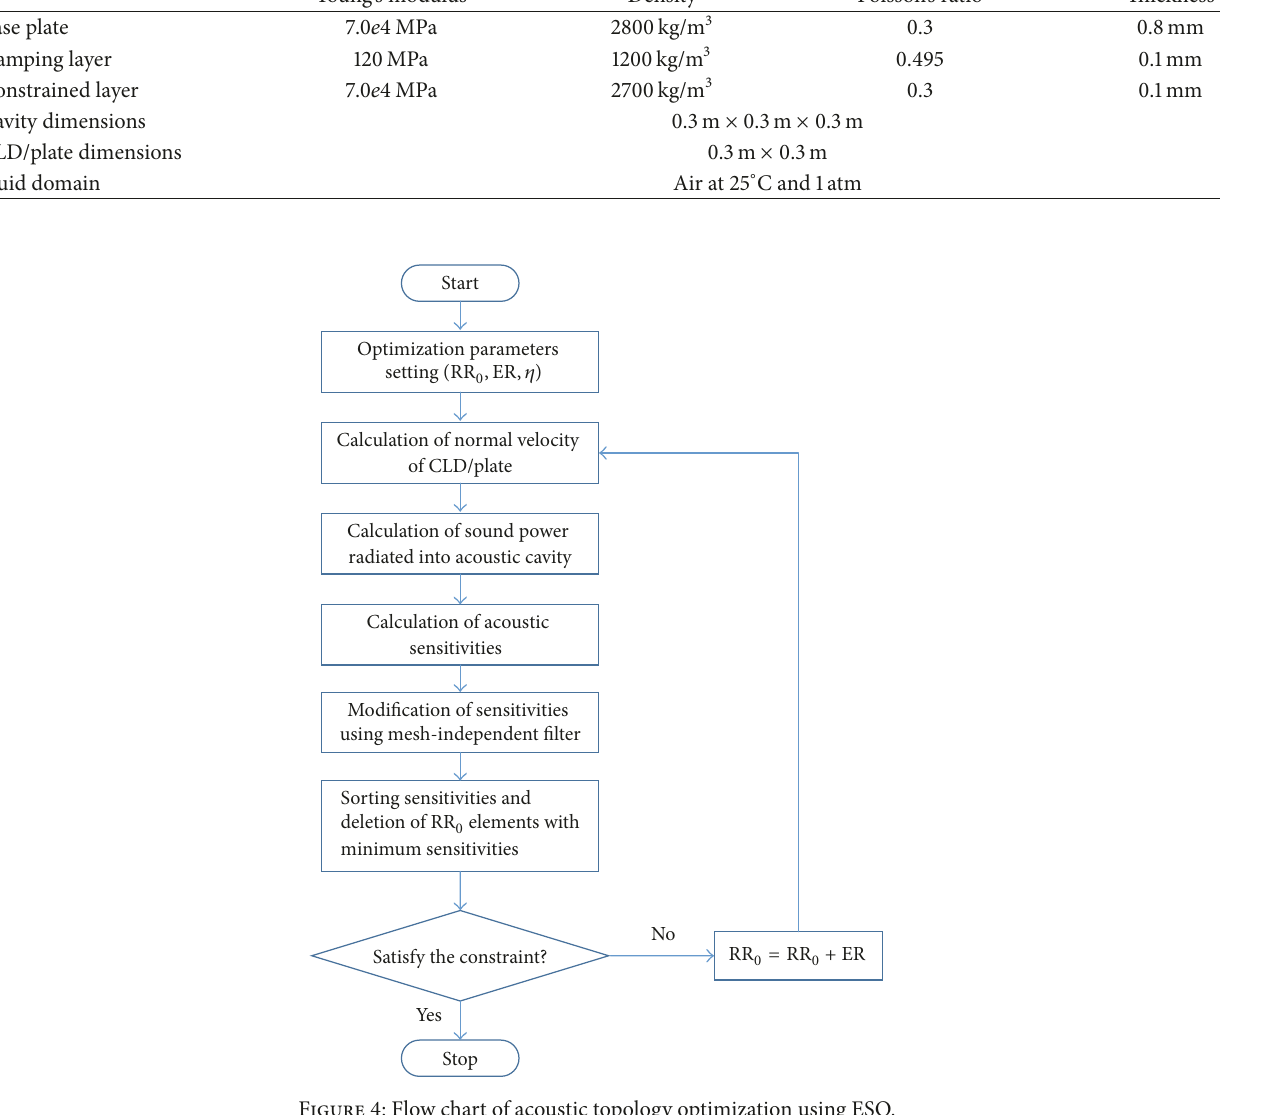
Figure 4: Flow chart of acoustic topology optimization using ESO.